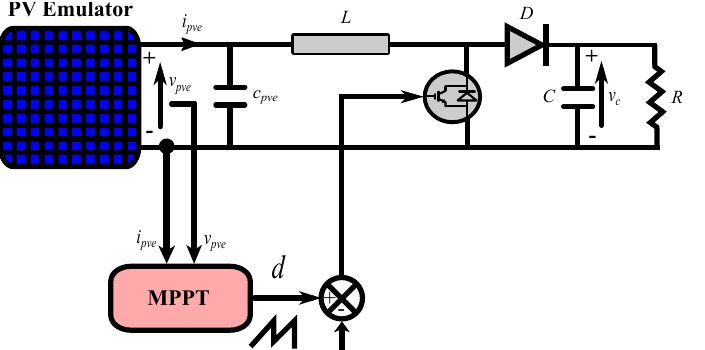
Figure 7. The considered PV emulation system for MPPT implementation.